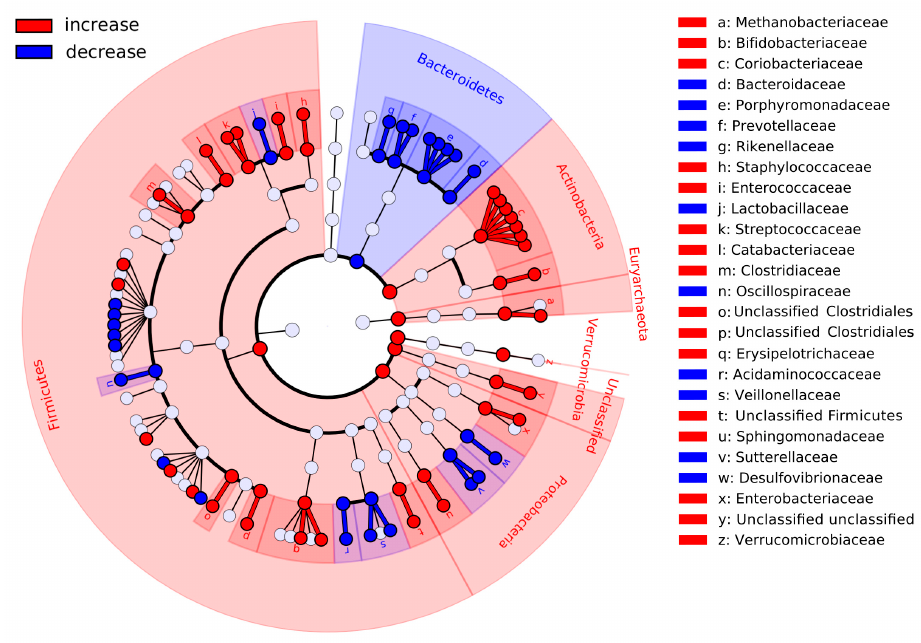
Figure 2. Major changes in the gut community structure of the volunteers after following the dietary recommendations. Red branches of the cladogram denote the taxa that were increased in abundance, while the blue ones—decreased. Significance criterion: p < 0.05 in metagenomeSeq model and log10 of the effect size >2 in LEfSe method ( n = 430 paired samples).